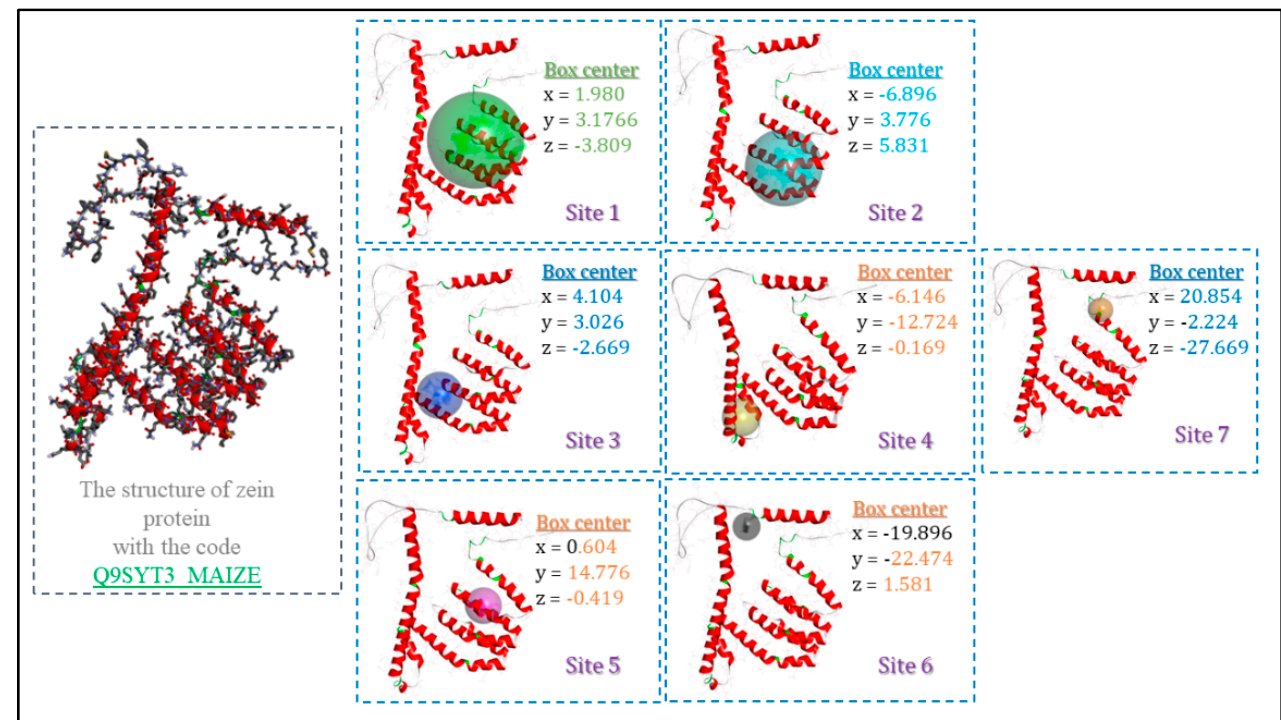
Figure 9. Different binding sites and their coordinates (x, y and z) on the surface of the zein structures (Q9SYT3_MAIZE) using Discovery Studio Client v16 software.